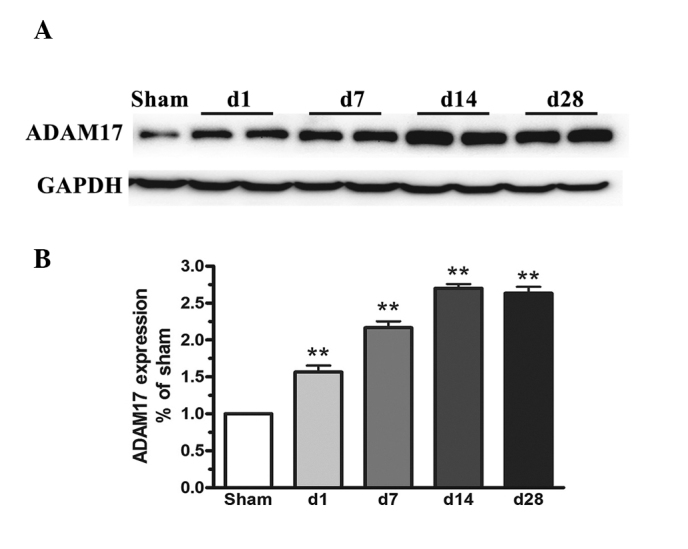
Expression of ADAM17 in spinal cord tissue samples from 1–28 days following spinal cord injury. (A) Representative western blot and (B) the expression ratio of ADAM17 to GAPDH are presented. The data are expressed as the mean ± standard deviation. Statistical analysis was performed using a one-way analysis of variance followed by Tukey’s test (n=3; **P<0.01, vs. 0 day control group). ADAM17, A disintegrin and metalloprotease 17.